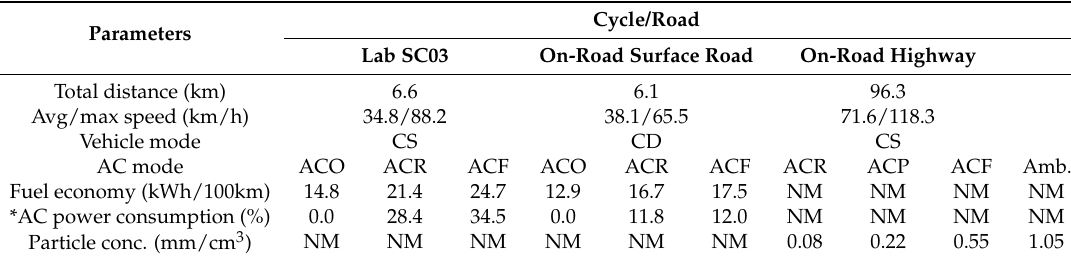
Table 2. Overview of the experimental design and